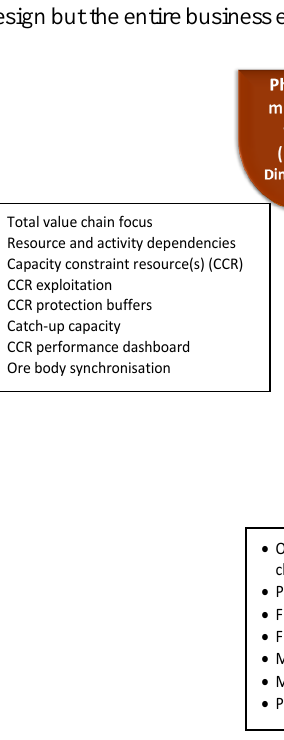
Figure 1: Illustration of the three dimensions of MRTM The application of TOC in complex mining environments is, however, limited due to several shortcomings in the theory and its application as alluded to earlier. The first major shortcoming of the TOC, as far as mining